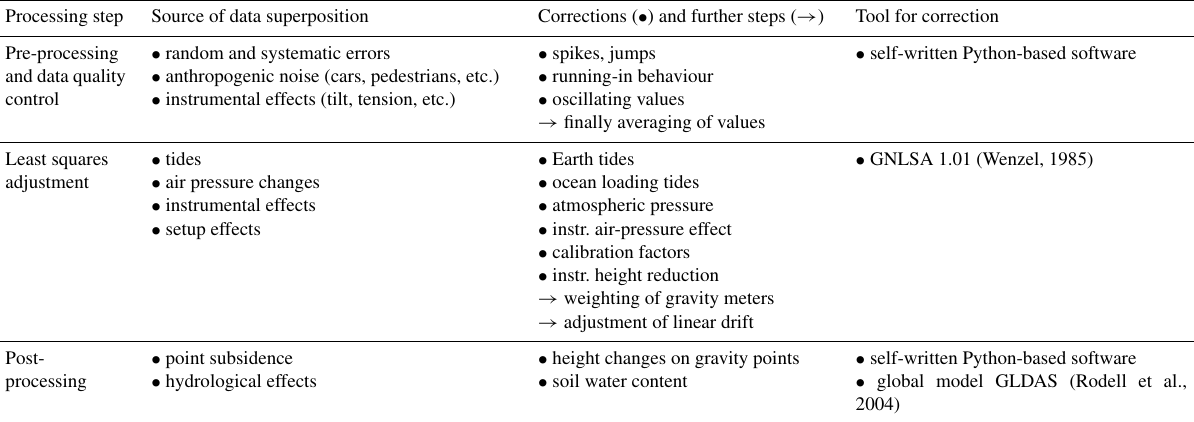
Table 1. Data processing steps on time-lapse gravity